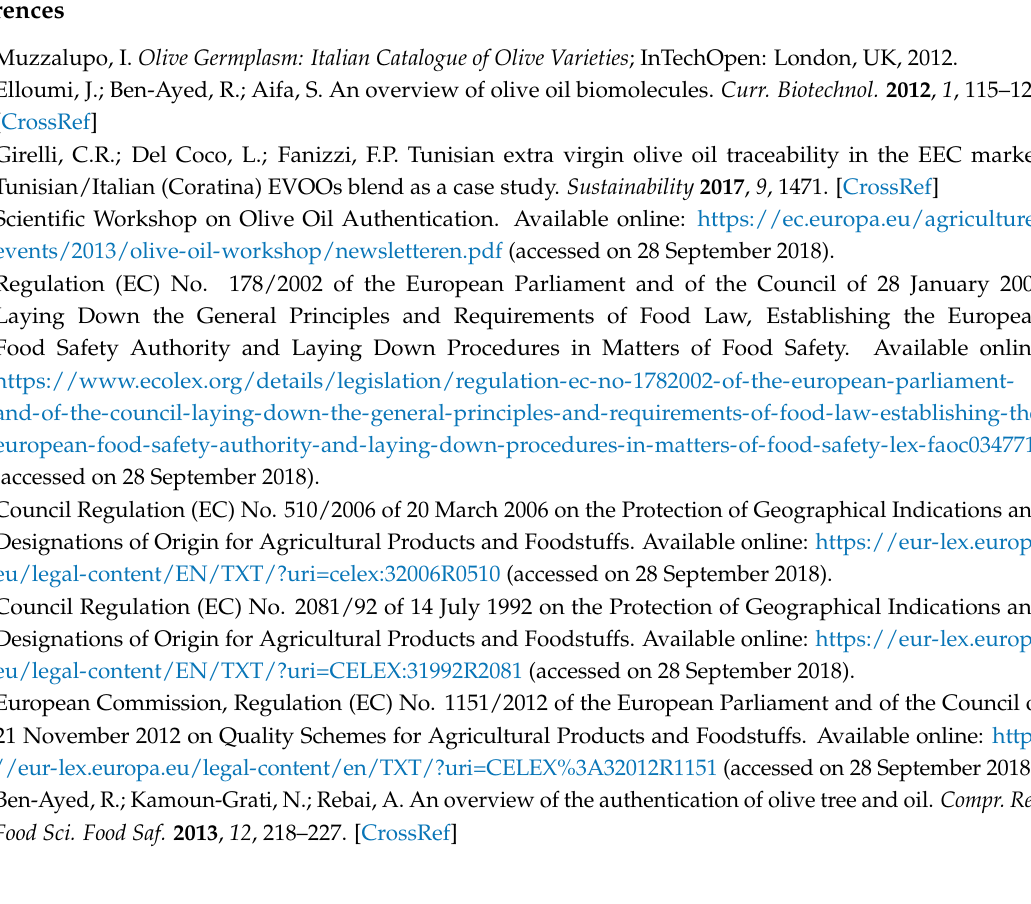
Table S1: List of olive samples from geographical areas within Tuscany region (Italy), Table S2: Molecular characterization results of the declared accessions collected in eight Tuscany areas, Table S3: Molecular profile of declared accessions correctly identified. In bold: allele variant from the reference cultivar, Table S4: Reference molecular profiles of Tuscan PGI declared cultivars in this work, Table S5: Classifier Output from Weka analysis, Figure S1: Representative 1 H NMR spectra of Moraiolo, Leccino, Frantoio olive oil samples. Figure S2: Data